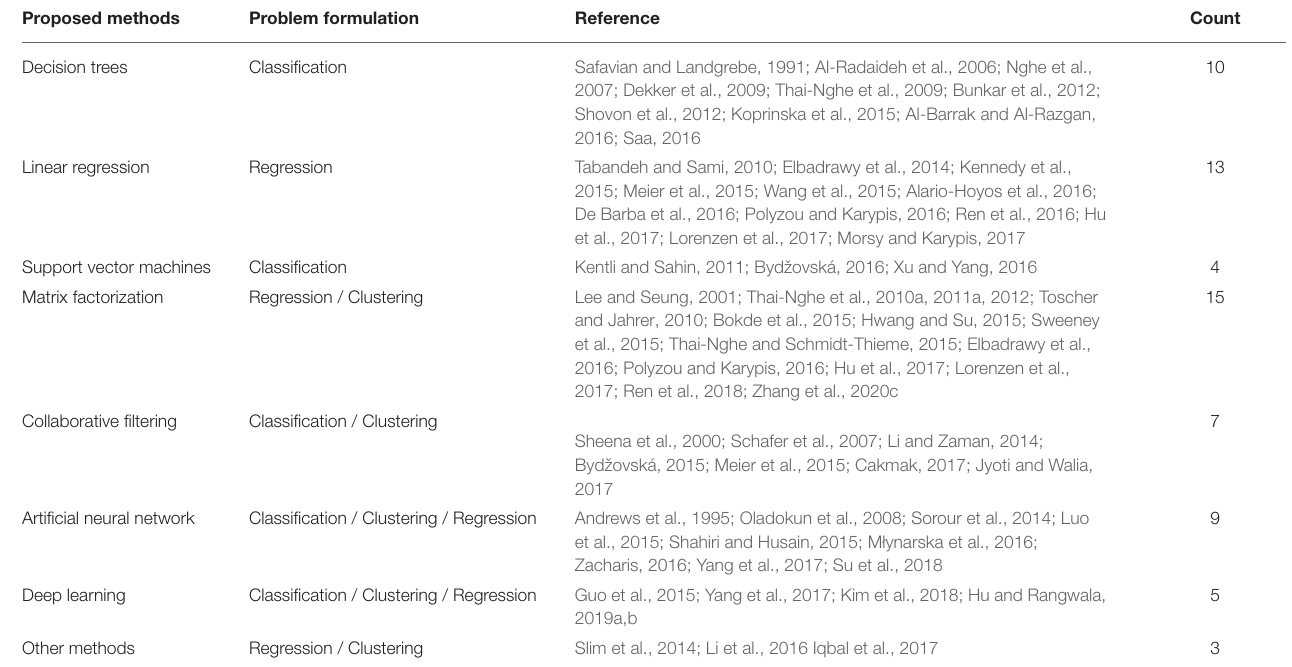
TABLE 2 | The related works with different machine learning